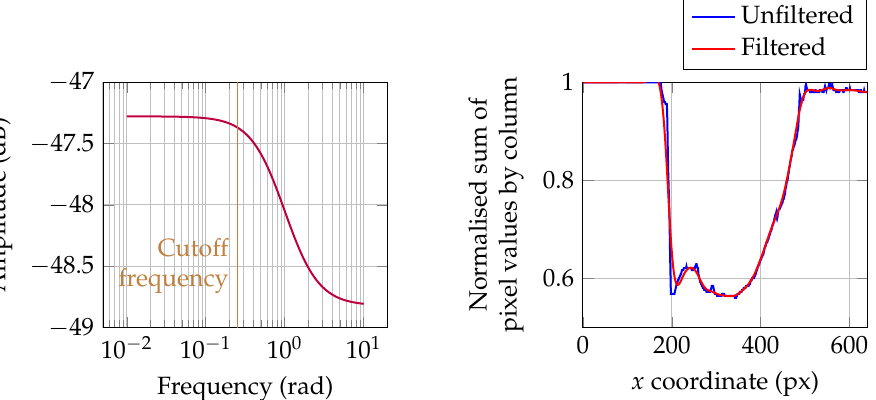
Figure 5. Frequency response pertaining to the sum of pixel values, by column, of the image belonging to track 33.